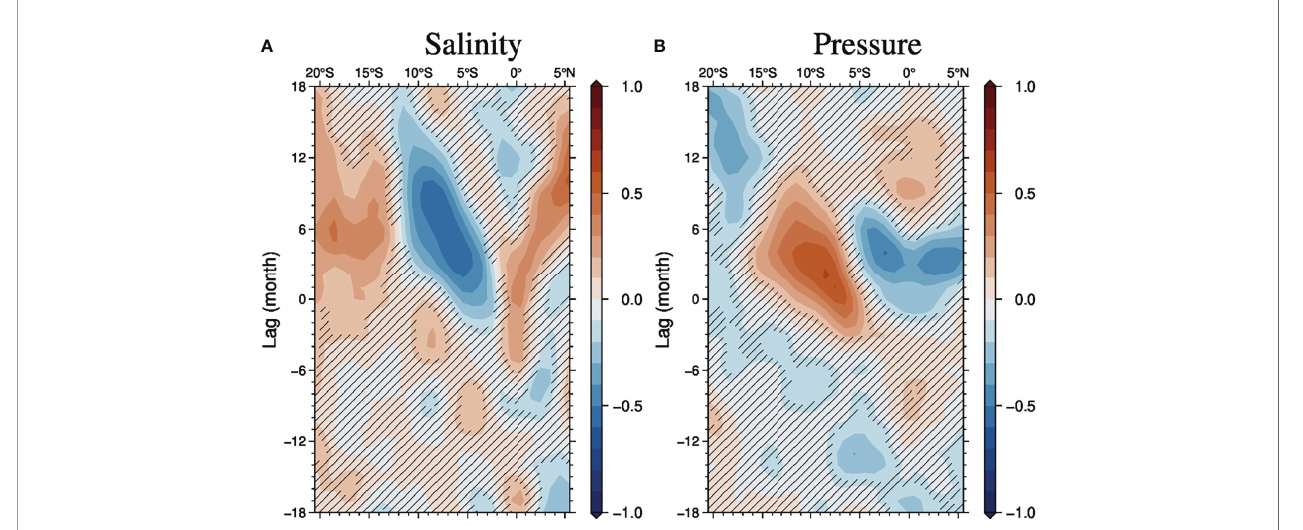
FIGURE 9 | Lead-lag correlations of salinity (A) and isopycnal depth (B) with DMI ( Figure 7 ) on 25.0 g along 80°E based on the Argo gridded dataset. The non- hatched areas correspond to areas of high signi fi cance (p-value